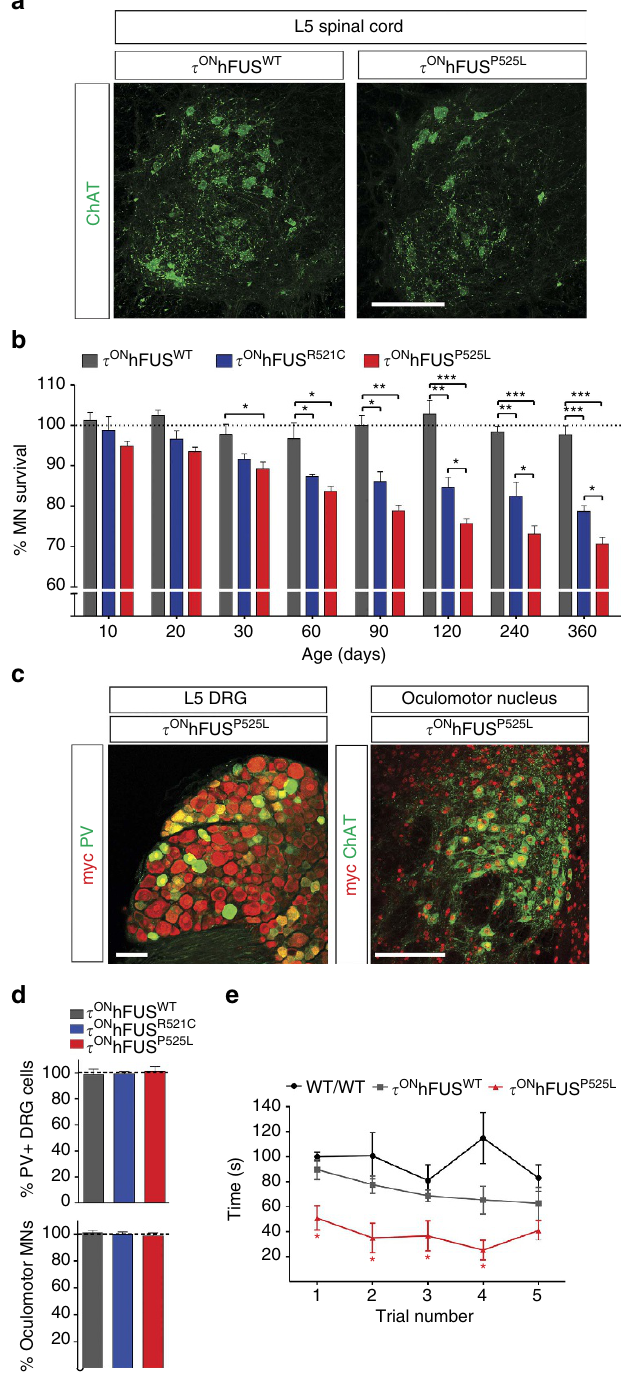
Figure 3 | Progressive and selective loss of motor neurons in the lumbar spinal cord of mice expressing ALS mutant FUS. ( a ) Representative images of L5 spinal cord cross-sections of control t ON hFUS WT and t ON hFUS P525L p360 animals immunostained with anti-ChATantibody. Scale bar, 100 m m. ( b ) MN survival in t ON hFUS WT (grey), t ON hFUS R521C (blue) and t ON hFUS P525L (red) animals calculated from the number of MNs in the L5 spinal cord normalized to that of non-transgenic wild-type controls (expressed as a percentage). ( c ) Representative images of parvalbumin- positive sensory neurons (PV, green, left) in the L5 DRG and MNs (ChAT, green, right) in the oculomotor nucleus in t ON hFUS P525L animals. Scale bar, 50 m m (left), 100 m m (right). ( d ) The number of parvalbumin-positive sensory neurons in the L5 DRG (left) and the number of MNs in the oculomotor nucleus (right) in p360 t ON animals normalized to non-transgenic wild-type controls (expressed as a percentage). ( e ) Evaluation of hind-limb motor function at p360 using the wire hang test. The latency for animals to fall was recorded over five trials with a 2-min rest period between each trial. (For b , d and e : N ¼ 4, * P o 0.05, ** P o 0.01 and *** P o 0.001 using one-way analysis of variance with Bonferroni’s post hoc test. Error bars represent